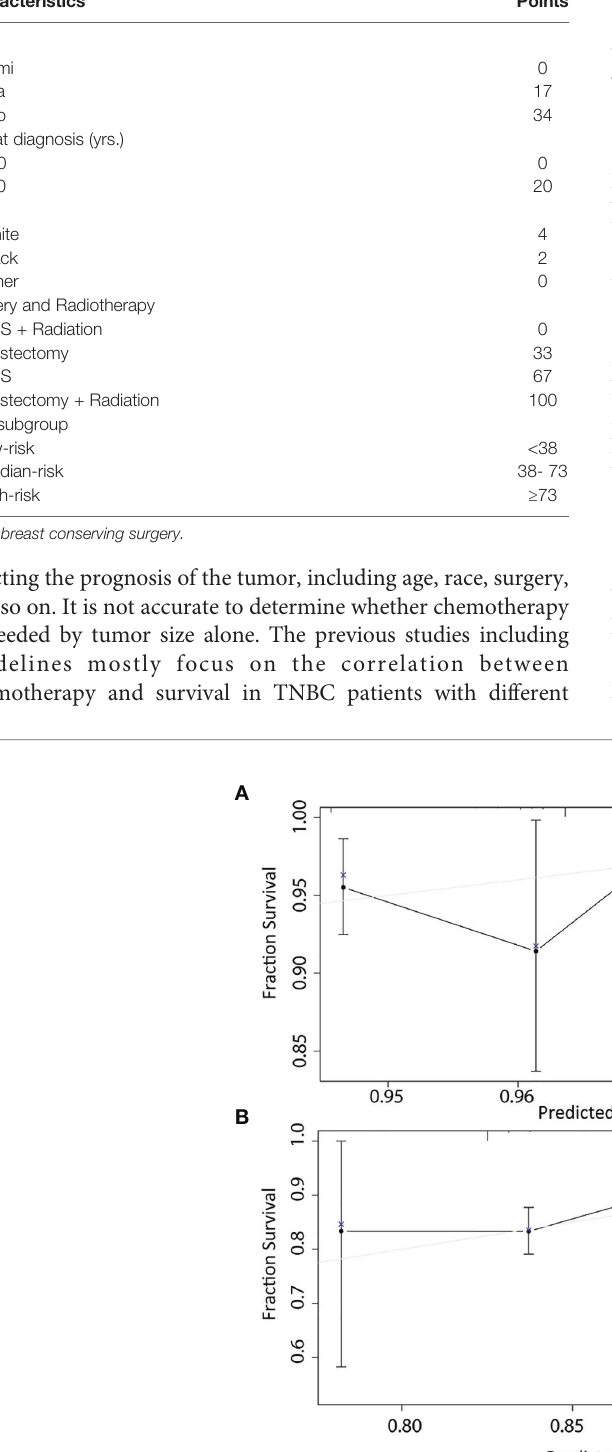
TABLE 3 | The risk score of each independent prognostic factor and the criteria for risk subgroup strati fi cation. Characteristics